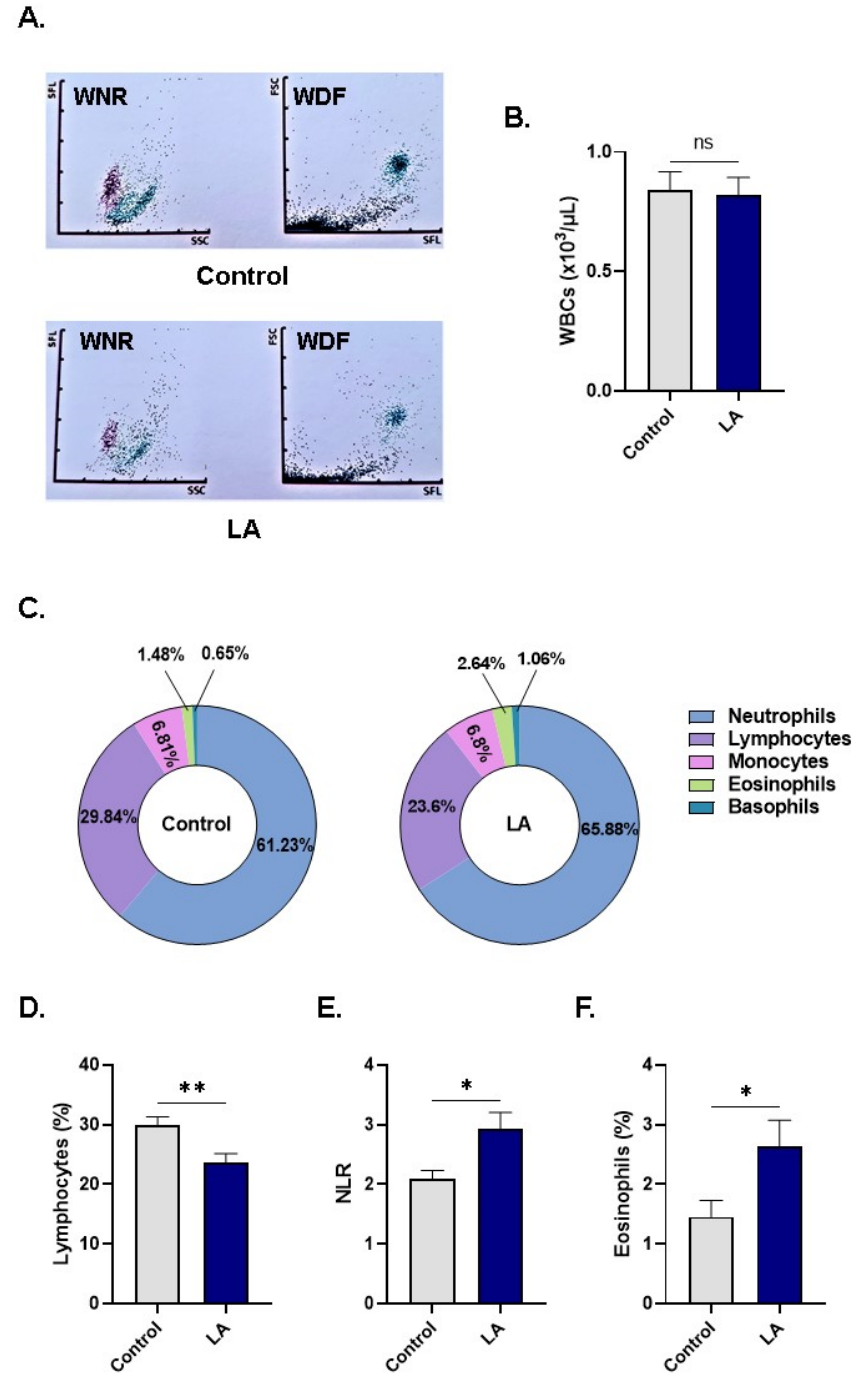
Figure 9. LA elevates NLR. ( A ) Representative dot plot scattergrams of control LA-treated peripheral WB cells. WNR channels show the distribution of WBCs in terms of side fluorescence (SFL) and SSC, while the WDF channel relates FSC and SFL. ( B ) Total WBC viability. ( C ) Differential count of WBC subsets. ( D ) Percentage of lymphocytes. ( E ) NLR. ( F ) Percentage of eosinophils. ns indicates not significant whereas * ( p < 0.05) and ** ( p < 0.01) indicate significantly different values from control